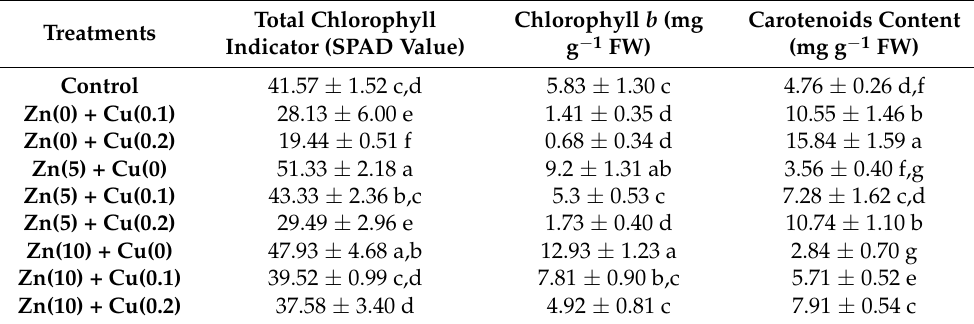
Table 3. The means related to interaction effects of added Cu and Zn to a basal nutritional solution on photosynthetic pigments of C. pepo . Total Chlorophyll Treatments